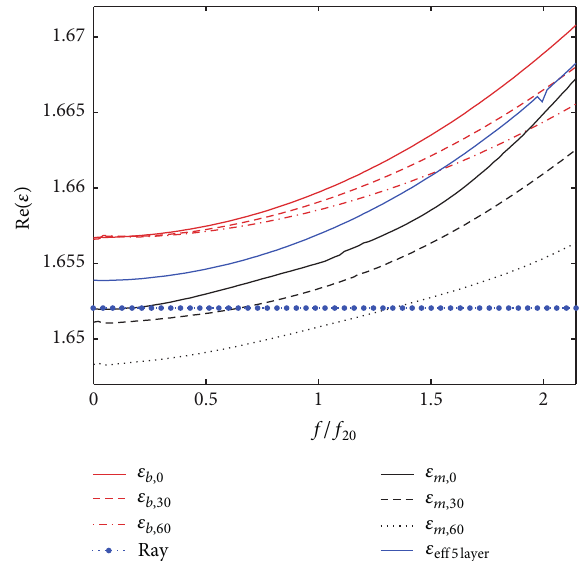
Figure 9: Retrieved permittivities of the inner and boundary layers curve denotes the effective at various incidence angles. The 𝜀 eff 5 layer permittivity of the H-model for the 5-layer slab; Rayleigh prediction is shown with dot marks; and the subscripts numeral, 𝑏 , and 𝑚 stand for the incidence angle, boundary layer, and inner layer,